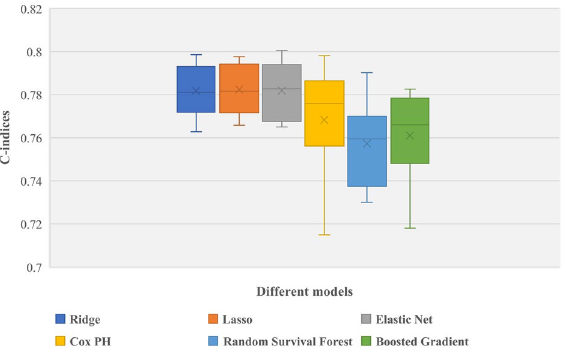
Figure 3. Boxplots showing the spread of values of the C-index produced by the different